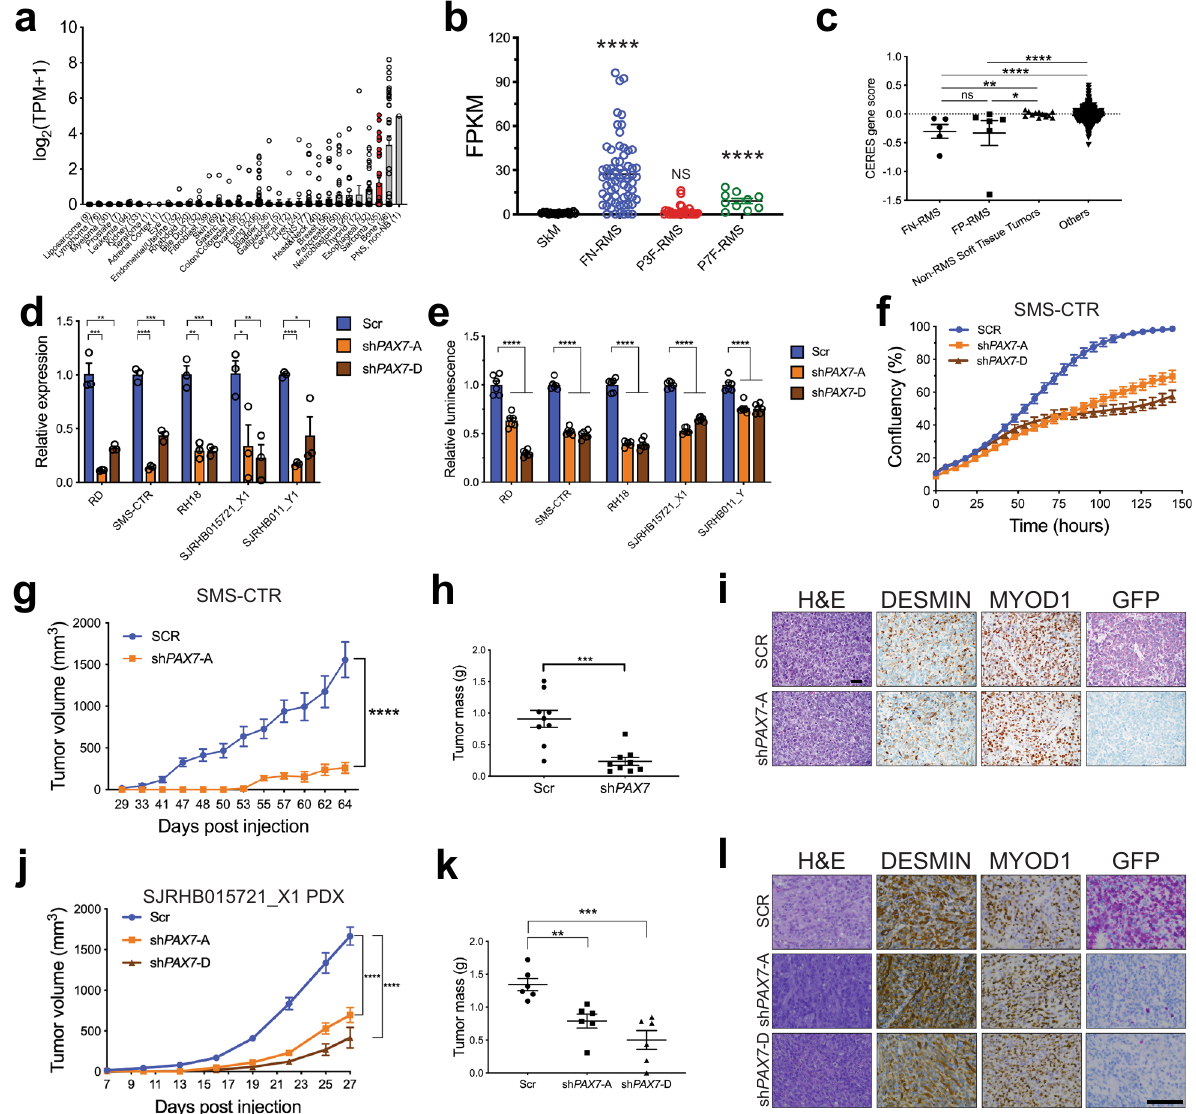
Fig. 6 Human FN-RMS is dependent on PAX7. a PAX7 expression by RNA sequencing (log 2 (TPM + 1)) from the DepMap (20Q3 release). Red bar indicates sarcoma cell lines. The number of cell lines is indicated along the x axis label for each respective tumor type. b RNA sequencing (FPKM) of PAX7 in human FN-RMS ( n = 64), FP-RMS (P3F-RMS n = 29, P7F- RMS n = 10) tumors, and human skeletal muscle ( n = 20) (SkM) from the NCI dataset 30 . (SkM-FN-RMS P < 0.0001, SkM-P7F-RMS P < 0.0001). c CERES gene dependency score for PAX7 in FN-RMS cells ( n = 5) compared to all other cell